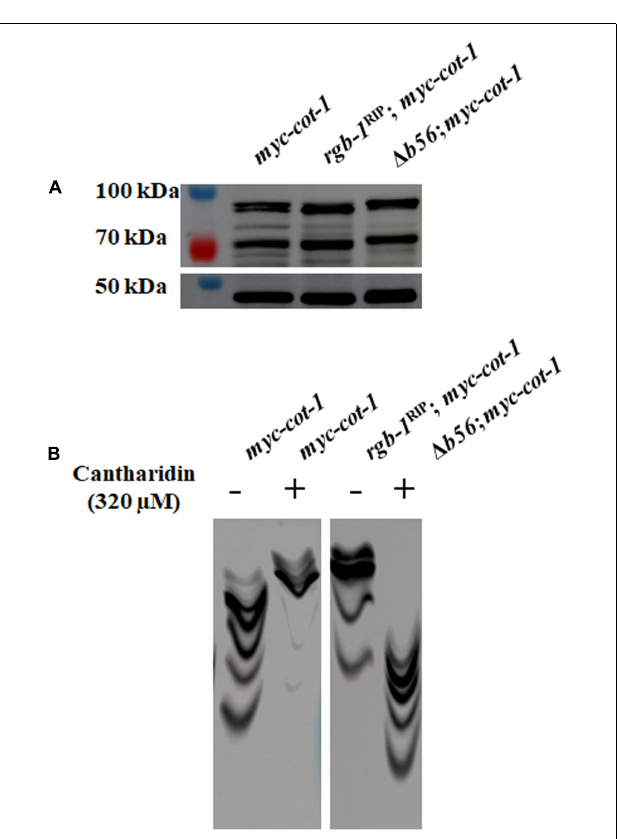
FIGURE 9 | Detection of COT1 forms by western blot analysis in rgb-1 RIP and (cid:49) b56 backgrounds. (A) As resolved using a standard SDS-PAGE system. (B) Effect of cantharidin (left panel) or mutation of the rgb-1 and b56 PP2A regulatory subunits (right panels) on COT1 phosphorylation state, as evident by the resolving patterns of COT1 forms on a Mn 2 + -Phos-tag TM SDS-PAGE system. MYC::COT1 was detected using anti-MYC antibodies.